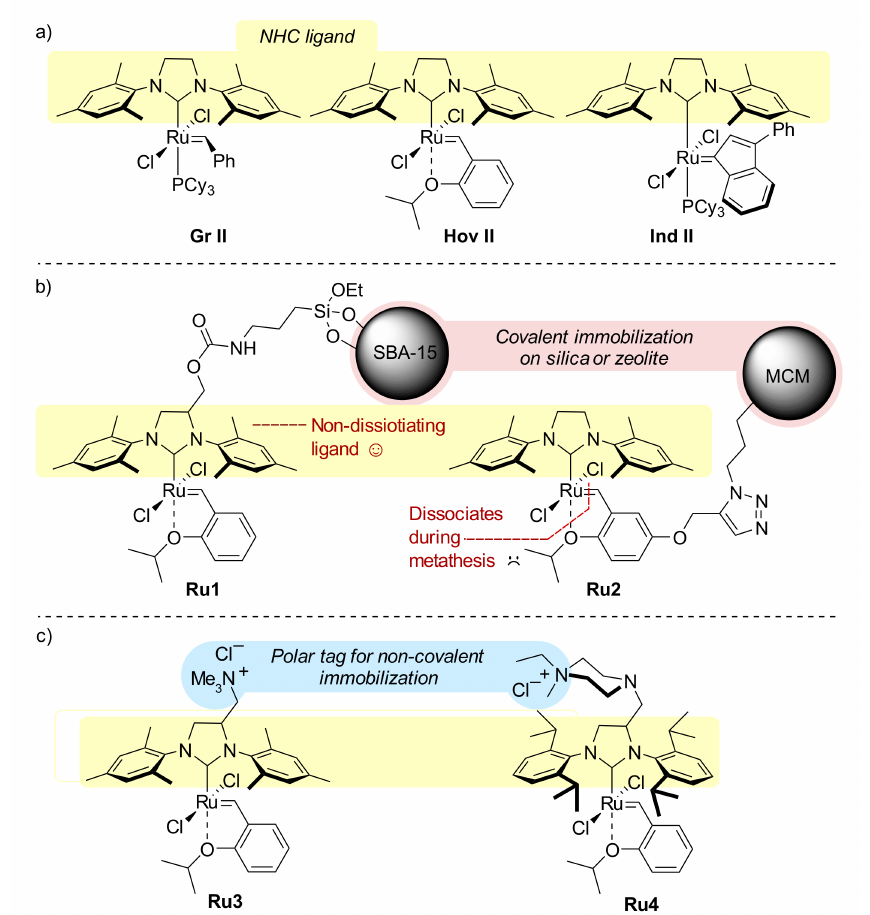
Figure 1. Selected ruthenium olefin metathesis catalysts: ( a ) Grubbs, Hoveyda-Grubbs, and indenyli- dene type general-use complexes. ( b ) Examples of complexes covalently bound to the support. ( c ) Examples of commercially available complexes bearing polar quaternary ammonium tags for non-covalent attachment to the support. Cy = cyclohexyl, SBA-15 = Santa Barbara Amorphous-15, a highly stable mesoporous silica sieve, MCM = class of micro- and mesoporous